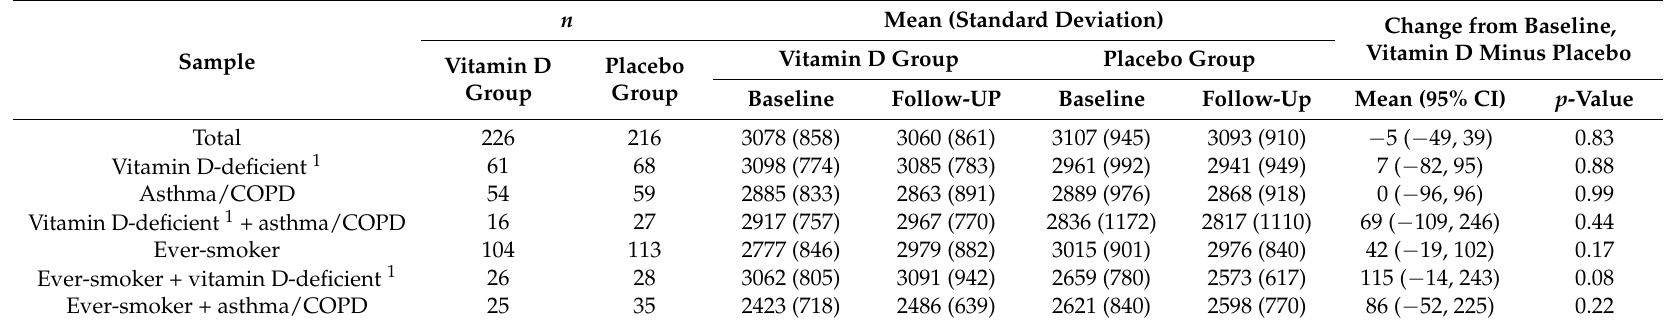
Table 3. Forced vital capacity (mL) at baseline and follow-up (adjusted for age, sex, ethnicity and height) by treatment group.